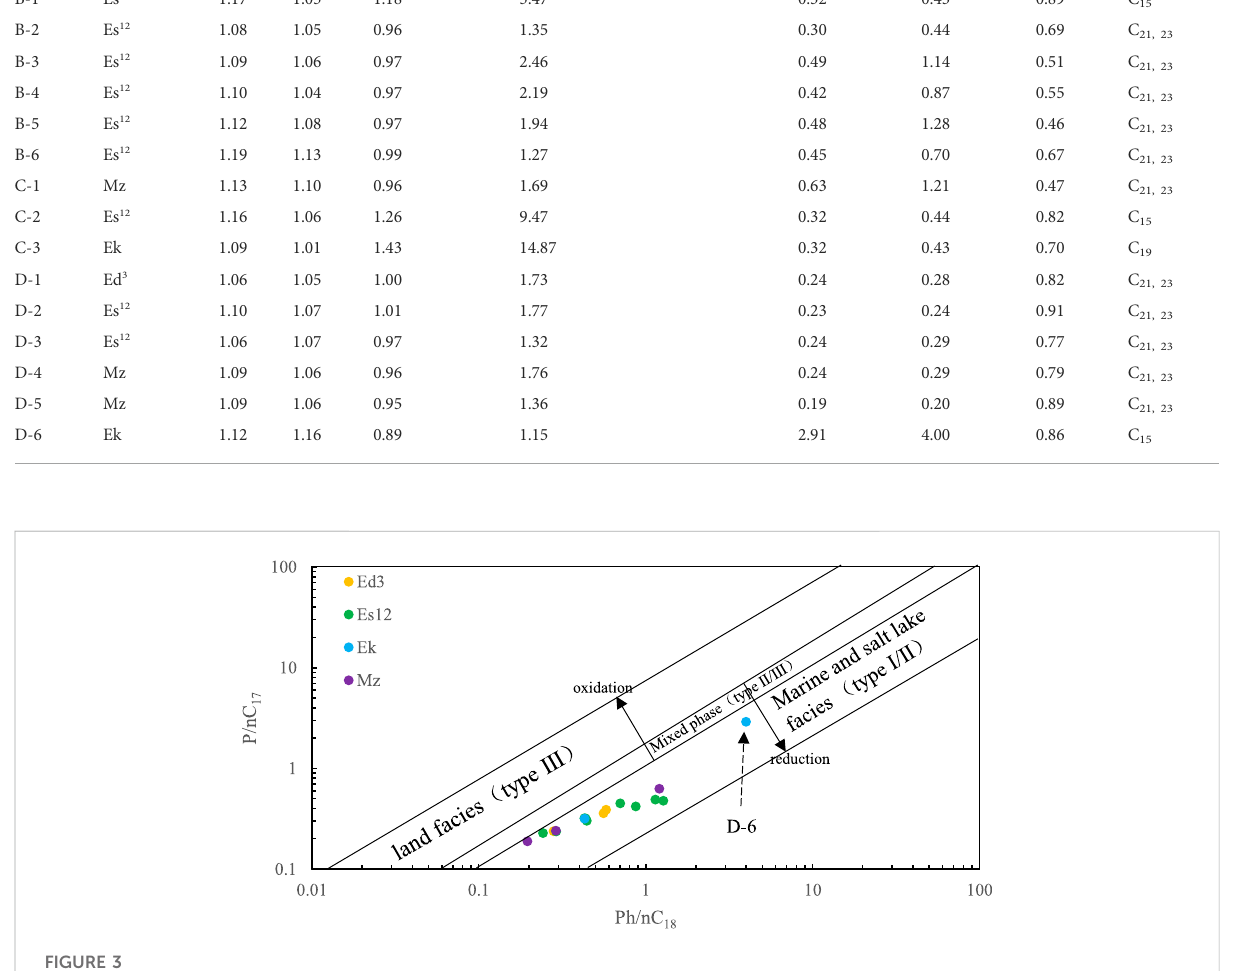
FIGURE 3 Cross plot of Pr/nC 17 and Ph/nC 18 of crude oil in Qinnan